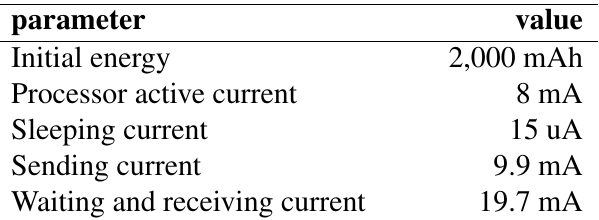
Table 2. Energy consumption